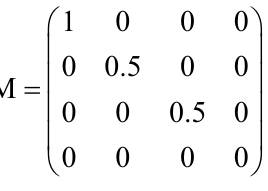
Travis [7]. In practice, the 4th row and